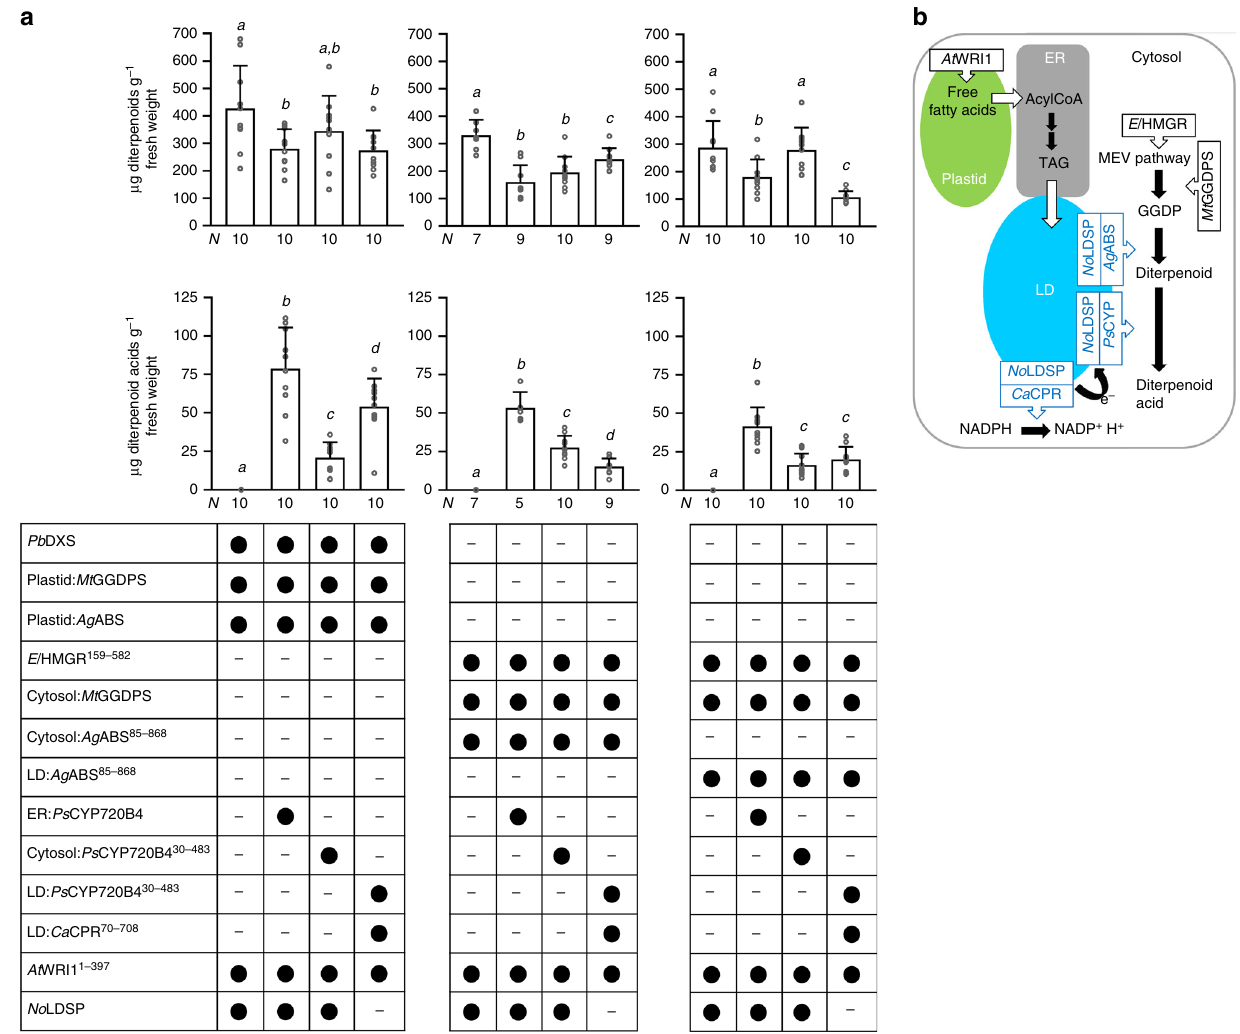
Fig. 5 Lipid droplets as engineering platform for the production of functionalized diterpenoids. Terpenoid biosynthesis enzymes were produced as No LDSP- fusion proteins to target them to the lipid droplets (LD: Ag ABS 85 – 868 , LD: Ps CYP720B4 430 – 483 , and LD: Ca CPR 70 – 708 ) and tested in different combinations as indicated below each bar (black circle, was included; minus, was not included) ( a ). Production of native or modi fi ed Ag ABS led to accumulation of diterpenoids and when native or modi fi ed Ps CYP720B4 was co-produced, to conversion of diterpenoids to diterpenoid acids. Data were analyzed by Shapiro – Wilk, Brown – Forsythe ANOVA (diterpenoids P < 0.0184, P < 0.0001, P < 0.0001; diterpenoid acids P < 0.0001, P < 0.0001, P < 0.0001) and Welch ANOVA (diterpenoids P < 0.0509, P 0.0002, P < 0.0001; diterpenoid acids P < 0.0001, P < 0.0001, P 0.0002) followed by t -tests (unpaired, two-tailed, Welch correction). Results are presented as individual biological replicates and bars representing average levels with SD ( N indicated below each bar). Statistically signi fi cant differences are indicated by a-d based on t -tests ( P < 0.05). This experiment was replicated twice. The scheme ( b ) depicts the conversion of abietadiene to abietic acid when LD: Ag ABS 85 – 868 ( No LDSP- Ag ABS), LD: Ps CYP720B4 430 – 483 ( No LDSP- Ps CYP) and LD: Ca CPR 70 – 708 ( No LDSP- Ca CPR) were produced. Source Data are provided as a Source Data fi le. LD, lipid droplet; e − , electron from